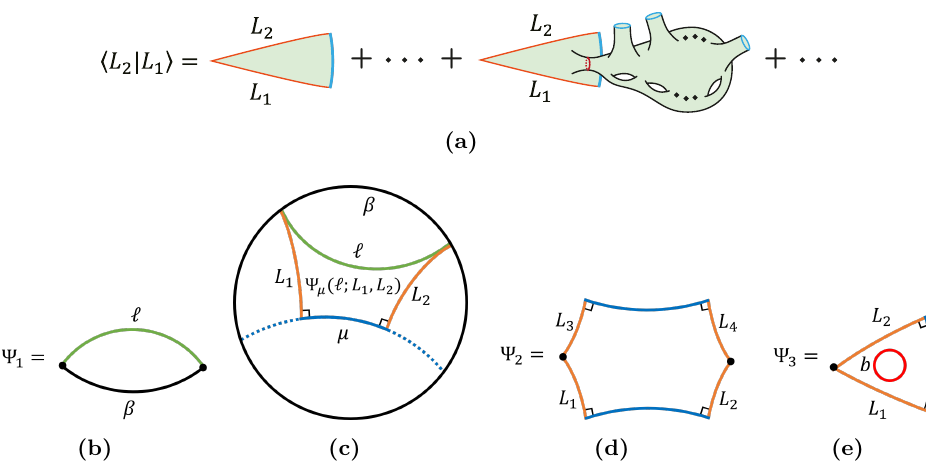
Figure 20. (a) Modified inner product of h L 2 | L 1 i by including handles and EOW brane loops in Euclidean path integral. Blue curve is EOW branes and orange curve is geodesic connecting AdS boundary and EOW brane. The red loop is a closed geodesic which bounds all nontrivial topologies. (b) to (e) are a few geometric building blocks to compute h L 2 | L 1 i , where black curves are AdS boundaries, green curves are geodesics connecting two points on AdS boundary, and red/blue/orange curves represent the same objects as (a). (b) Ψ 1 is the wavefunction of the Hartle-Hawking state of two-sided AdS system in JT gravity. (c) Ψ µ ( ‘ ; L 1 , L 2 ) is a propagator G µ,β ( L 2 , L 1 ) with a Ψ 1 pinched off. (d) Ψ 2 is gluing of two Ψ µ along l . (e) Ψ 3 is gluing of L 3 with L 4 in Ψ 2 with one EOW brane measure M ( b ) pinched off. Topological contribution to modified inner product h L 2 | L 1 i is Ψ